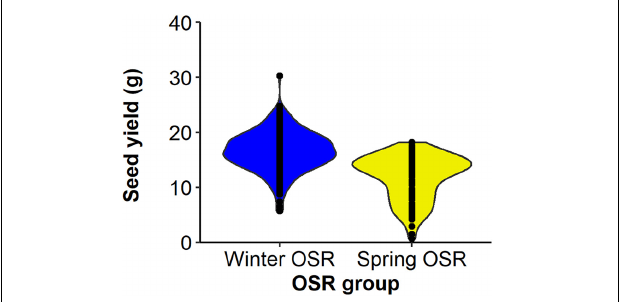
FIGURE 2 | Distribution of seed yield (g) for Winter OSR and Spring OSR ( n = 5). Points represent the individual observations for the genotypes in each group.